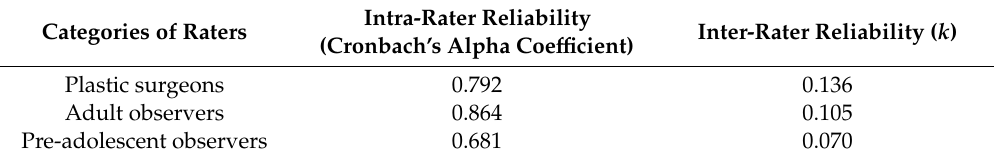
Table 3. Intra and interrater reliability for facial asymmetry / symmetry